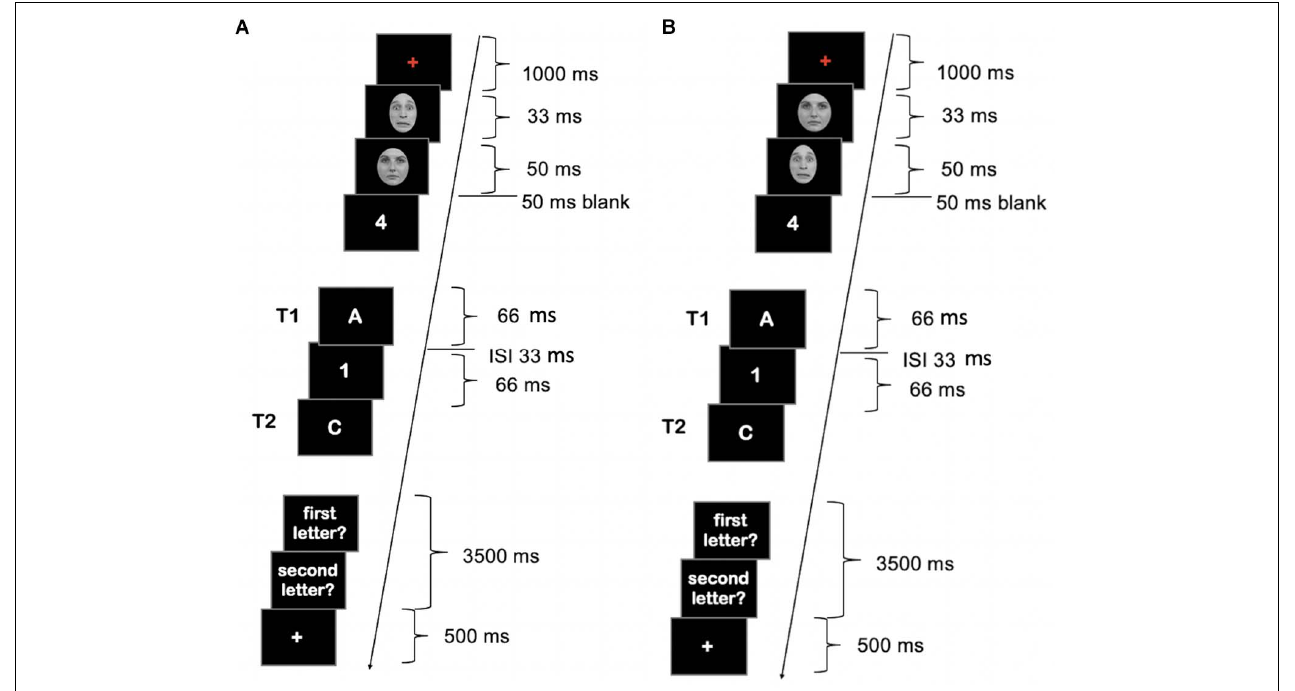
FIGURE 5 | Schematic illustration of the AB stream in Experiment 2. (A) Masked condition. (B) Unmasked condition. Face images were obtained from the Radboud Faces Database (Langner et al., 2010) and are reprinted in line with the guidelines of the database.